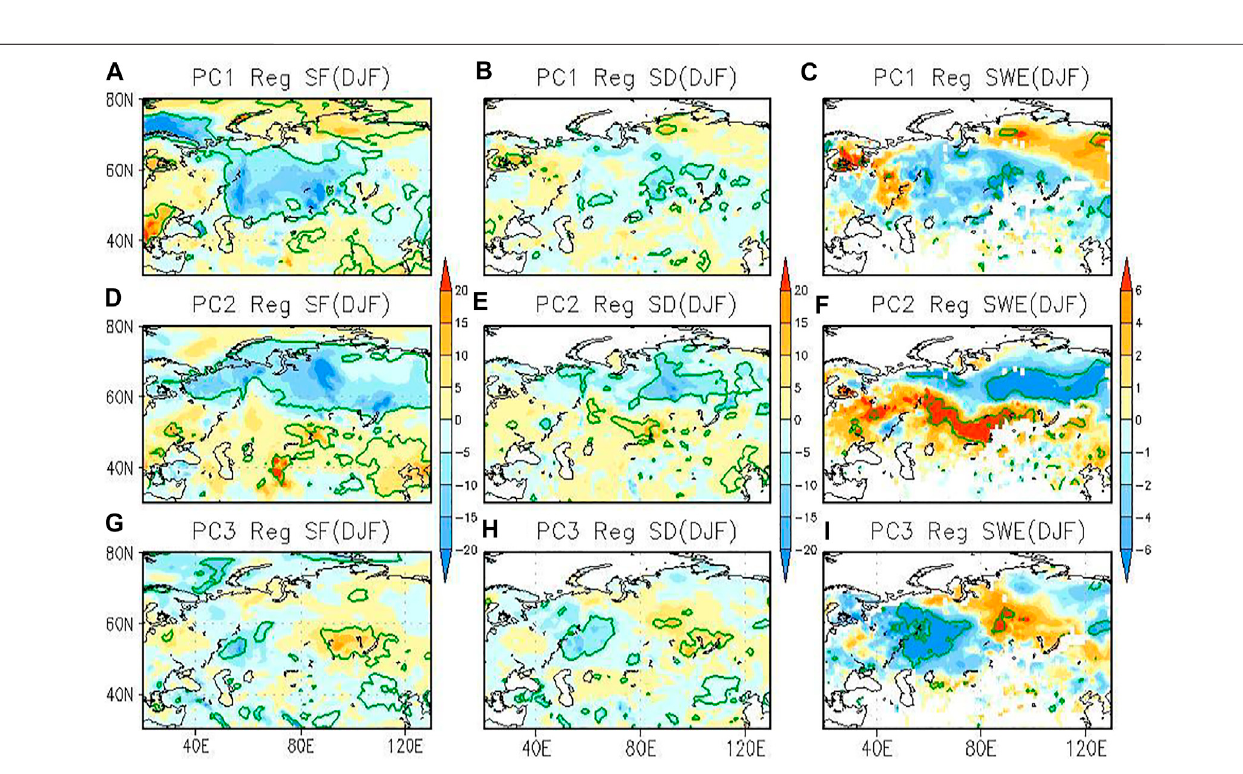
Frontiers in Earth Science |